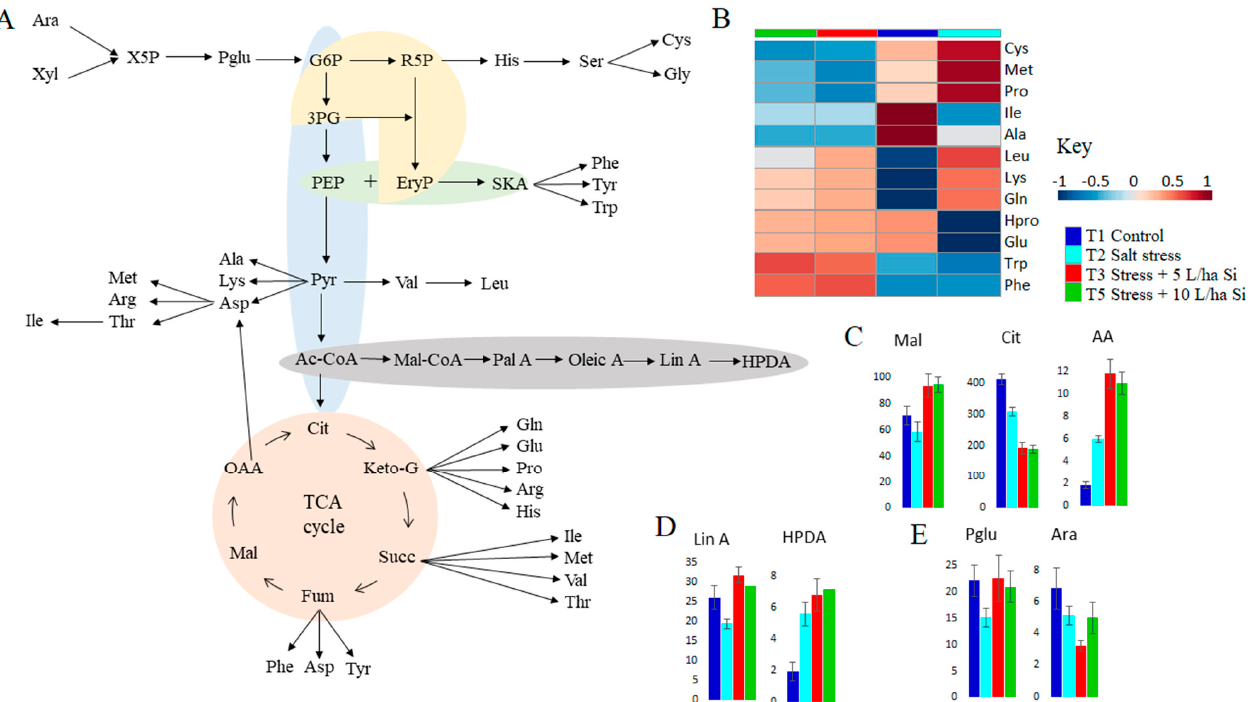
Figure 5. A graphical/topological representation of the intertwined pathways and relative quantification of measured primary metabolites. ( A ) The pathways incorporated include the phosphate pentose pathway (PPP) (yellow), glycolysis (blue), shikimic acid (green), organic acid/TCA cycle (brown), the fatty acid biosynthesis (grey) and several amino acid biosynthesis pathways. ( B ) Heatmap showing relative quantification of measured amino acids across non-stressed controls (T1), salt stressed (T2) and Si treated (T3 and T5) plants. Relative levels (integrated peak areas) of organic acids ( C ), fatty acids ( D ) and sugars ( E ) is depicted by bar graphs across non-stressed controls (T1), salt stressed (T2) and Si treated plants (T3 and T5), with error bars Abbreviations: Ara, arabinose; Xyl, xylose; X5P, xylose − 5 − phosphate; G6P, Glucose − 6 − phosphate; R5P, Ribose − 5 − phosphate; 3PG, 3 − phosphoglyceric acid; EryP, Erythrose 4 − phosphate; PEP, Phosphoenol pyruvate; SKA, shikimate; Pyr, Pyruvate; Cit, Citrate; Keto-G, ketoglutarate; Succ, Succinate; Fum, Fumarate; Mal, Malate; OAA, Oxaloacetate, TCA, Tricarboxylic acid.